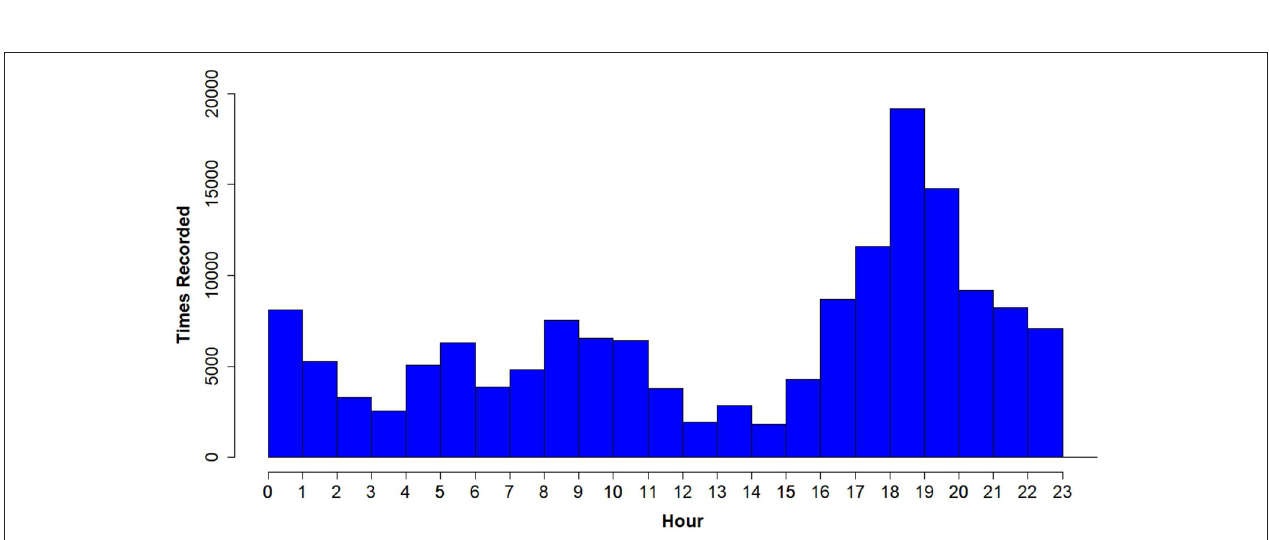
FIGURE 8 | Total number of times PIT tagged prairie voles were recorded (hits) from all RFID antennas per hour of the day (days where live-trapping took place, which may bias activity results, were removed). Note the peak in readings in the evening, from hours 18:00 to 20:00h.